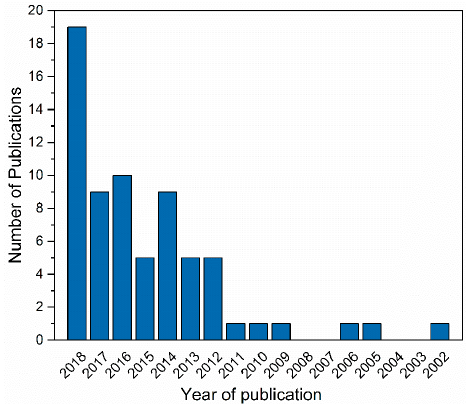
Figure 2. Journal papers published on FSW of dissimilar Al alloy joints.